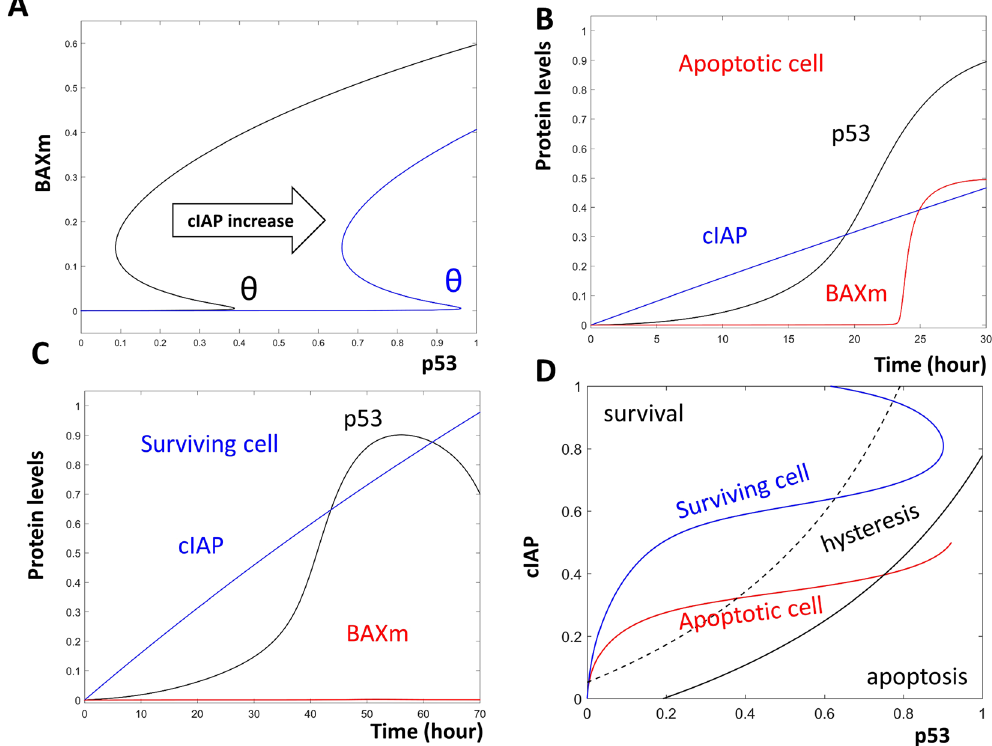
Figure 3. Dynamical analysis of fractional killing. ( A ) One parameter bifurcation analysis for the activation of BAXm by p53. The black curve indicates BAXm level as a function of the level of p53. At low levels of p53, BAXm is inactivated; after the level of p53 increases over the threshold (black θ ), BAXm is activated. The blue curve indicates the elevated BAXm threshold (blue θ ) after the level of CIAP is increased. ( B ) Time series simulation of an apoptotic cell. In this cell, p53 (black curve) is activated early, when the level of CIAP (blue curve) is low. As a result, BAXm (red curve) is activated. ( C ) Time series simulation of a surviving cell. In this cell, p53 is activated after CIAP levels have already increased. Hence, BAXm remains inactive. ( D ) Two parameter bifurcation analysis with p53 and CIAP as control parameters. The black curve indicates the threshold of BAXm activation. At the right of this black solid curve, BAXm is activated and the cell undergoes apoptosis (labelled as “apoptosis”). The black dashed curve indicates the threshold of BAXm inactivation, at the left of this dashed curve, BAXm is inactive and the cell survives (labelled as “survival”). Between the solid and the dashed curve, is the predicted hysteretic area. The red and blue curves indicate the time dependent trajectories of the apoptotic and the surviving cells, as shown in ( B and C